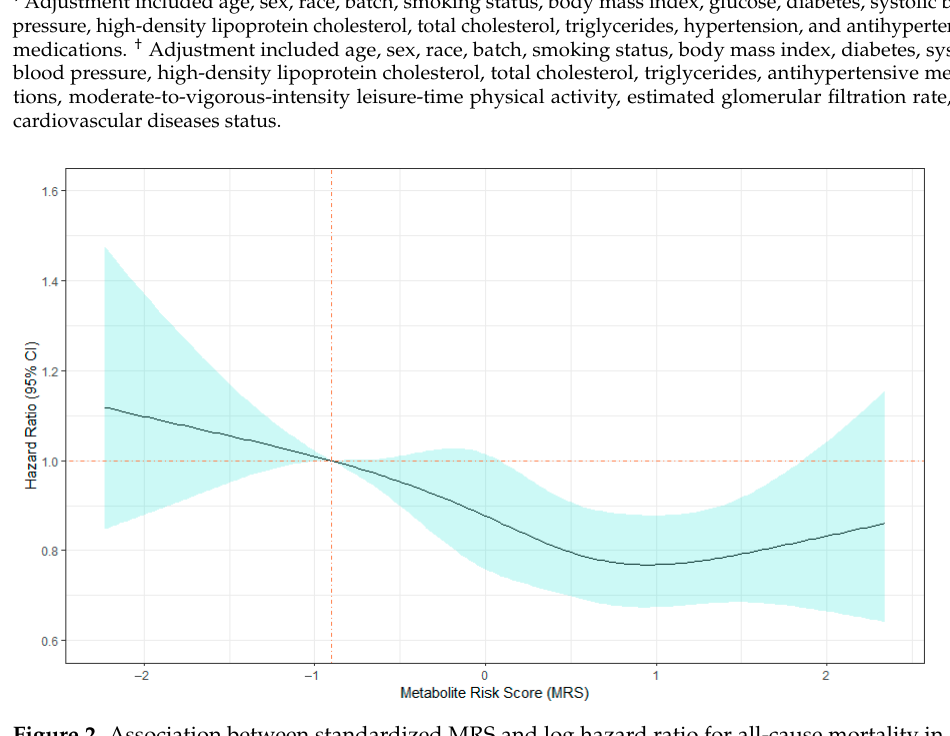
* Adjustment included age, sex, race, batch, smoking status, body mass index, glucose, diabetes, systolic blood pressure, high-density lipoprotein cholesterol, total cholesterol, triglycerides, hyper- tension, and antihypertensive medications. † Adjustment included age, sex, race, batch, smoking status, body mass index, diabetes, systolic blood pressure, high-density lipoprotein cholesterol,